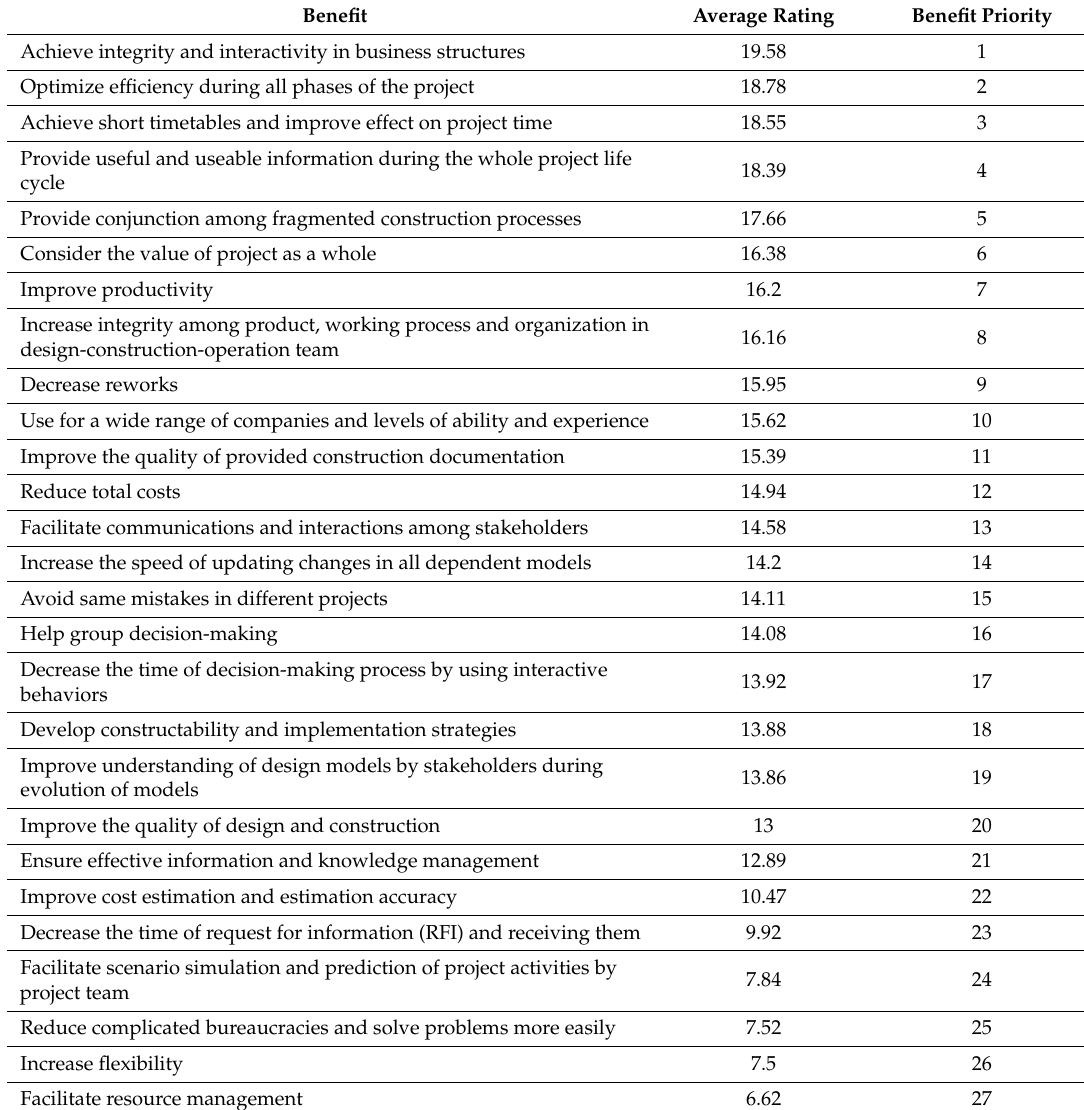
Table 8. Average rating of benefits of VIM among the confirmed